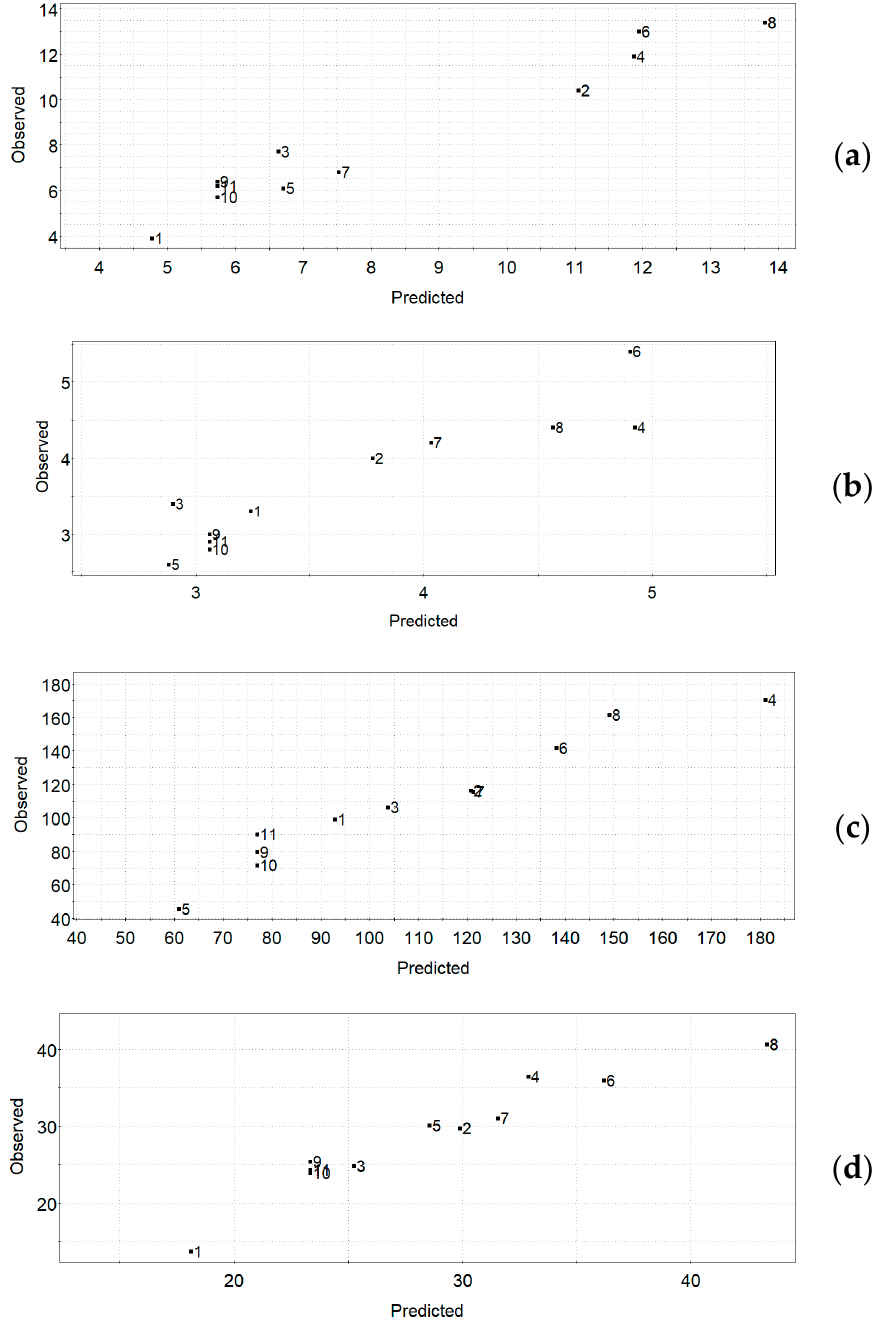
Figure 1. UAE experimental design. Observed vs. predicted plots for the responses: ( a ) TPC, ( b ) TFC, ( c ) FRAP, ( d )